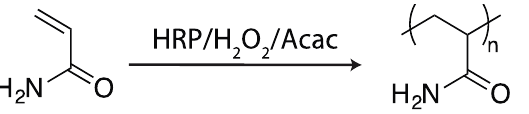
Figure 3. Acrylamide is polymerized into poly(acrylamide) in the presence of HRP, hydrogen peroxide, and acetylacetone (Acac) [22,31–33].